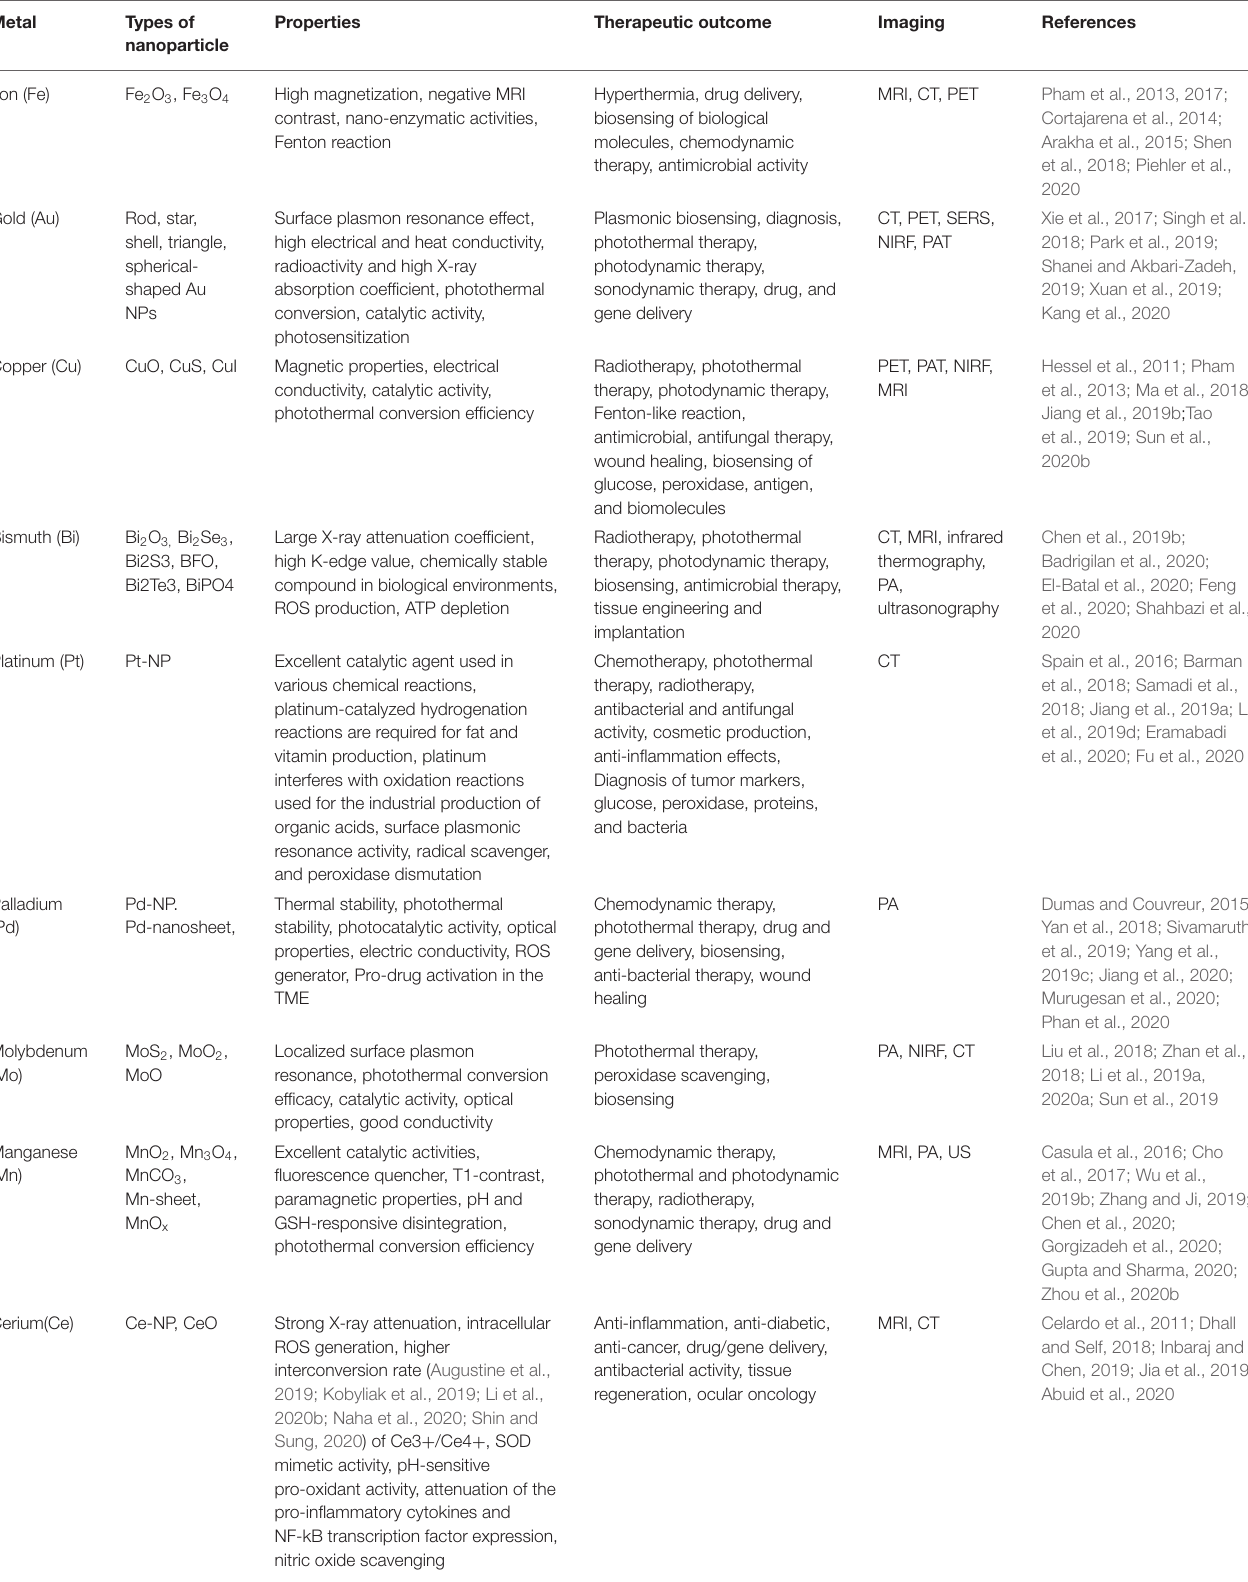
TABLE 1 | General properties and therapeutic applications of metallic